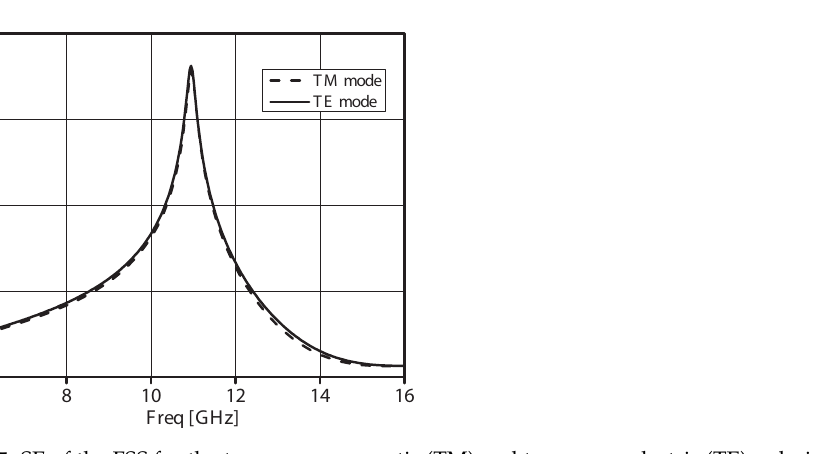
Figure 5. SE of the FSS for the transverse magnetic (TM) and transverse electric (TE) polarizations at a normal angle of incidence.